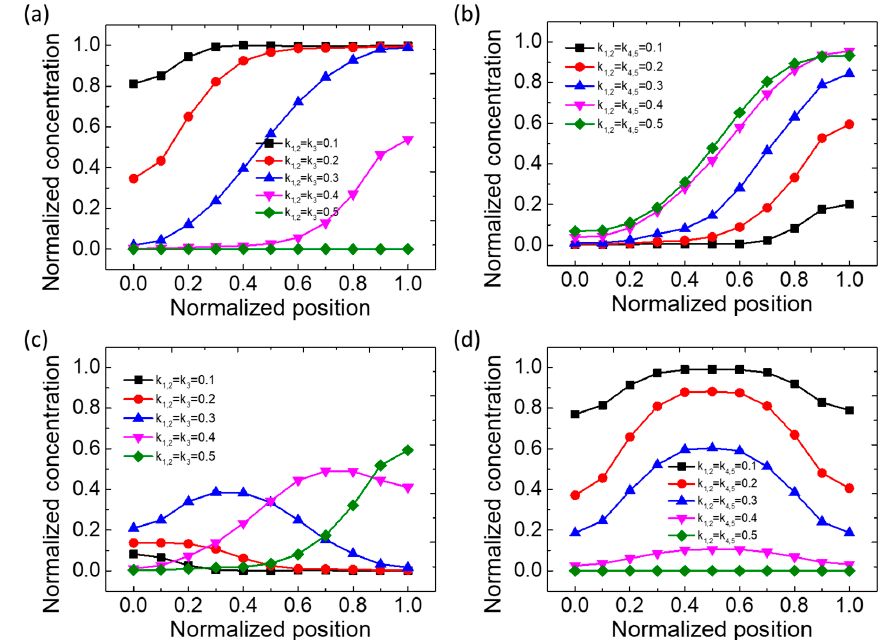
Figure 4. Numerical simulation results of normalized concentration as a function of normalized position at the outlet of the type V microfluidic device. ( a – d ) show the cases of C = (0, 0, 0, 1, 1) and Q 1,2 = Q 3 , Q 4,5 ; C = (0, 0, 0, 1, 1) and Q 1,2 = Q 4,5 , Q 3 ; C = (0, 0, 1, 0, 0) and Q 1,2 = Q 3 , Q 4,5 ; and C = (0, 0, 1, 0, 0) and Q 1,2 = Q 4,5 , Q 3 , respectively.